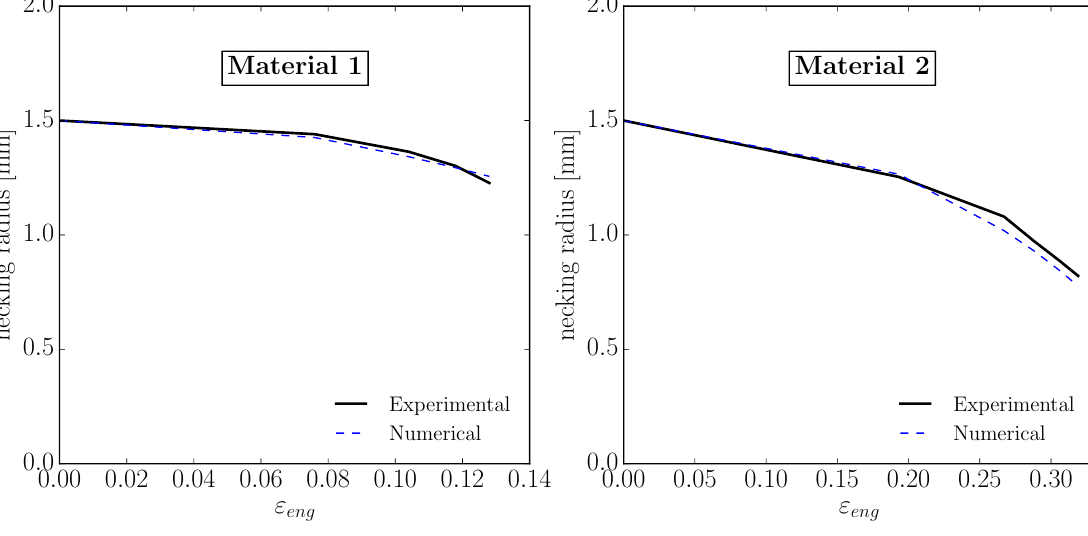
Figure 14. Necking radius evolution for Material 1 (left) and Material 2 (right); numerical and experimental results are compared.